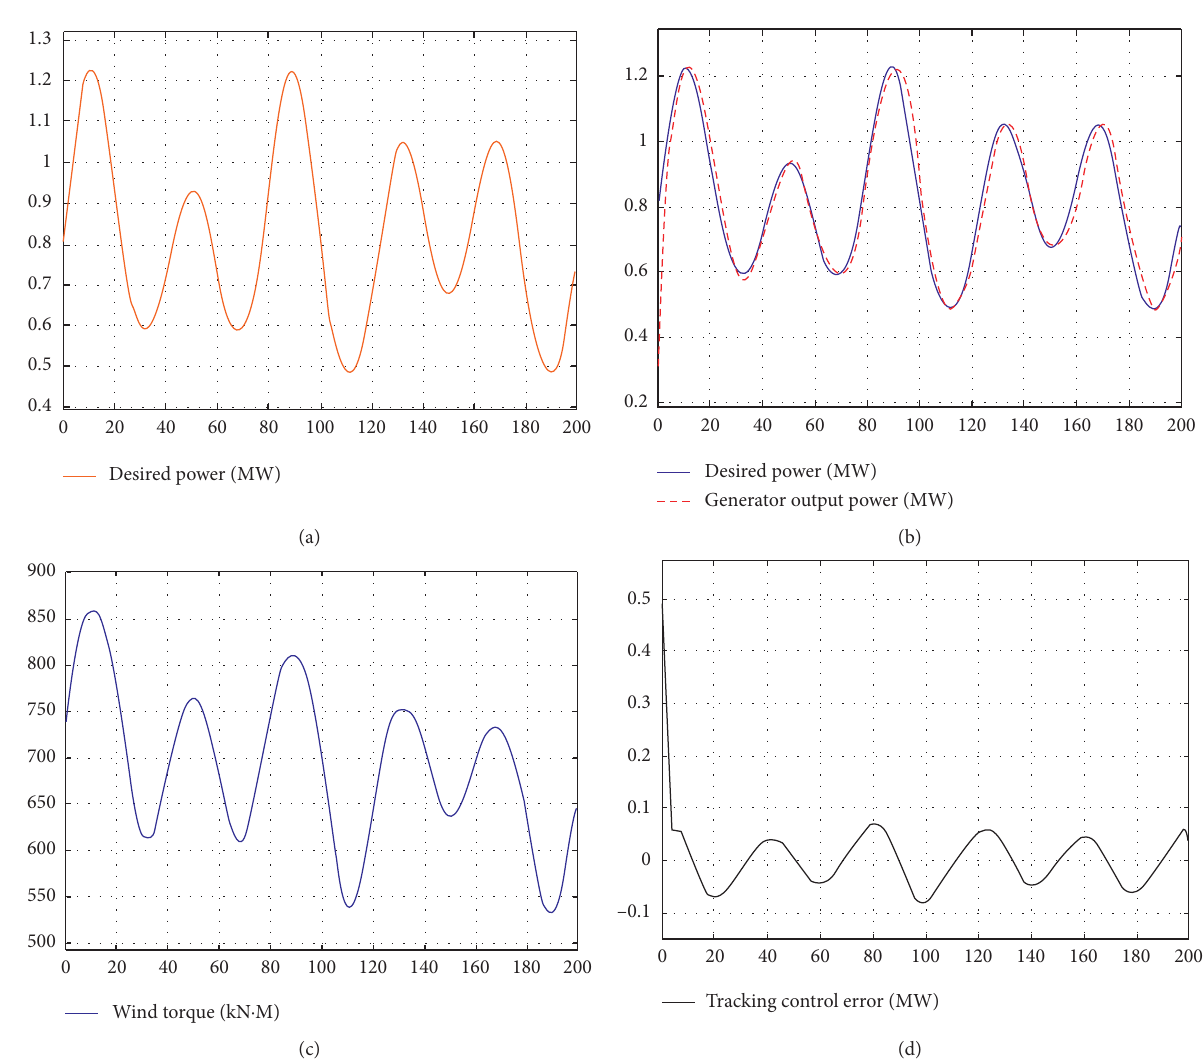
Figure 10: (a) Effective wind speed v ( t ) . (b) Desired power P control error between P d ( t ) and P g ( t )